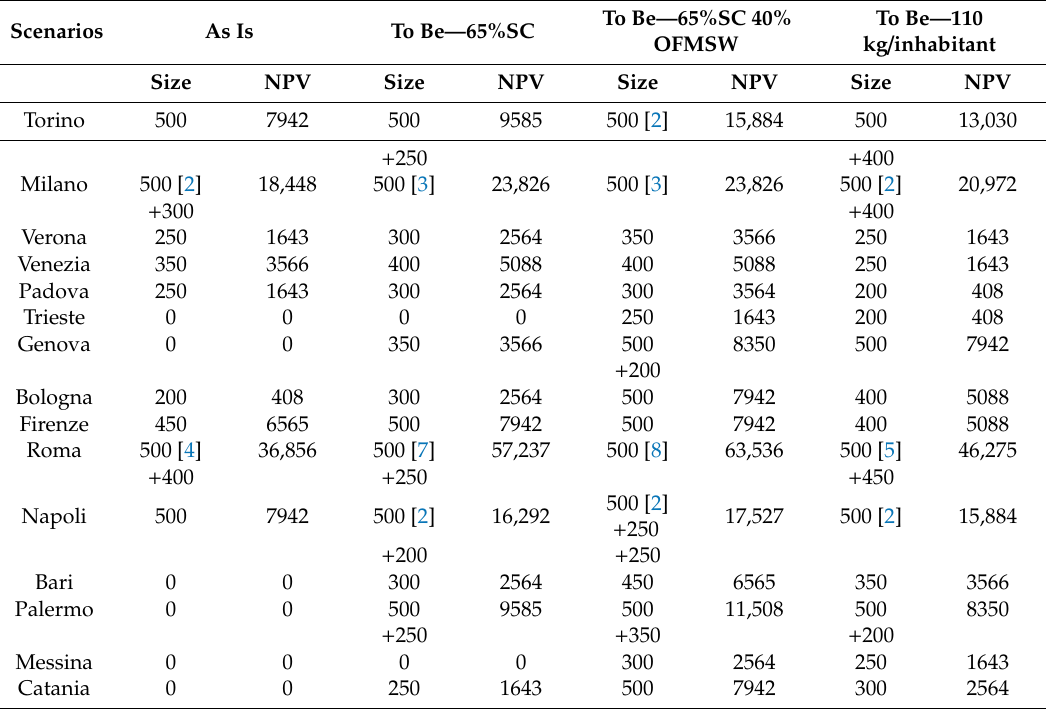
Table 9. Definition of plant size and calculation of economic profit (thousand € )—baseline scenario. NPV—net present